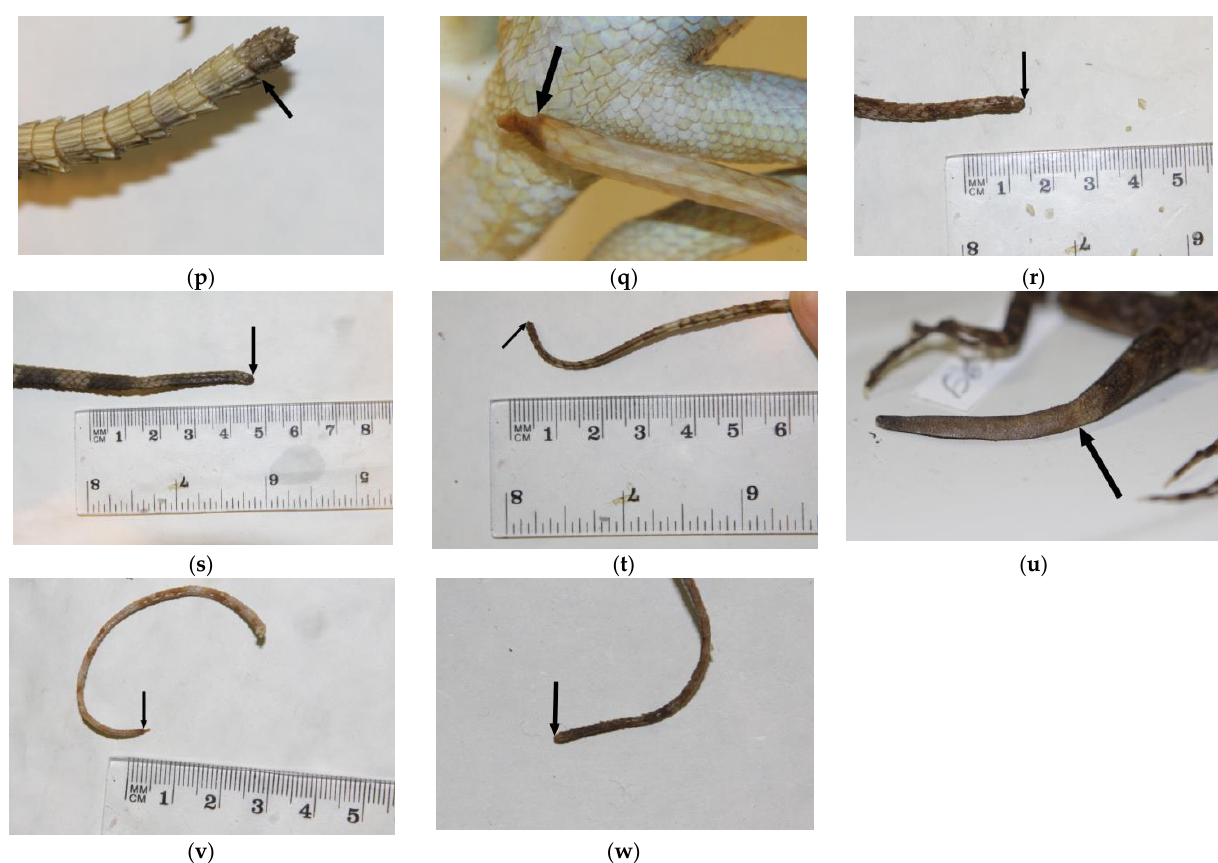
Figure A1. Fragments of the tail, demonstrating cases of its loss and the formation of regenerate (if any) in agamid lizards: ( a ) Leiolepis belliana (ZISP 17166); ( b ) Leiolepis guentherpetersi (ZISP 21877); ( c ) Leiolepis guttata (ZISP 20354); ( d ) Leiolepis reevesii (ZISP 20355); ( e ) Intellagama lesueurii (ZISP 20455); ( f ) Lophosaurus spinipes (ZISP 20466); ( g ) Physignathus cocincinus (ZISP 22567); ( h ) Laudakia nupta (ZISP 11397); ( i ) Laudakia tuberculata (ZISP 20424); ( j ) Paralaudakia caucasia (ZMMSU R- 7308); ( k ) Paralaudakia erythrogaster (ZISP 18844); ( l ) Paralaudakia himalayana (ZMMSU R-9151); ( m ) Paralaudakia lehmanni (ZISP 19964); ( n ) Paralaudakia microlepis (ZMMSU R-11916); ( o ) Paralaudakia stoliczkana (ZISP 20220); ( p ) Stellagama stellio (ZISP 23479); ( q ) Calotes calotes (ZISP 935); ( r ) Calotes versicolor (ZISP 20237); ( s ) Gonocephalus chamaeleontinus (ZISP 2469); ( t ) Gonocephalus liogaster (ZISP 18573); ( u ) Mantheyus phuwuanensis (ZISP 30629); ( v ) Otocryptis wiegmanni (ZISP 3420); ( w ) Pelturagonia nigrilabris (ZISP 18546). Arrows show the plane of autotomy.